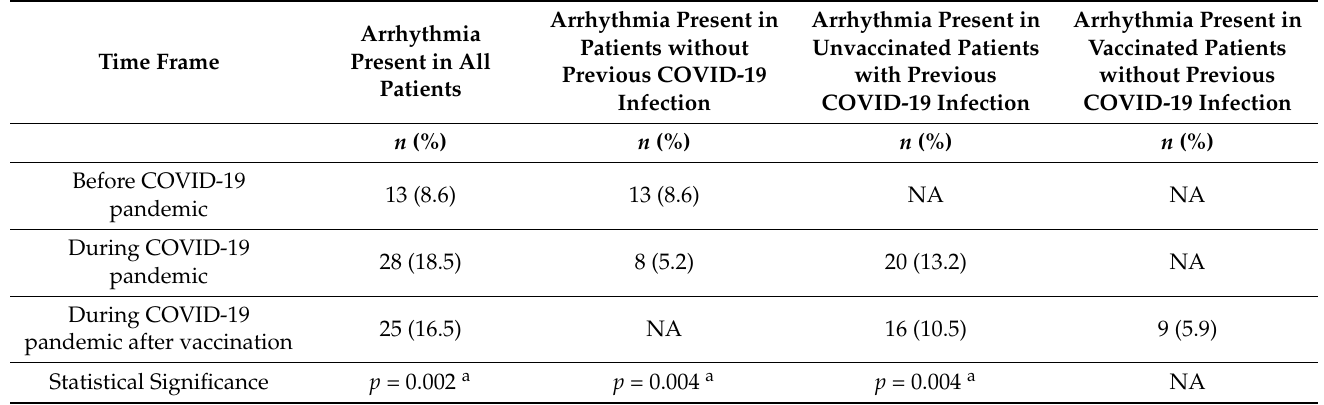
Table 4. Presence of heart rhythm disorder in study population.